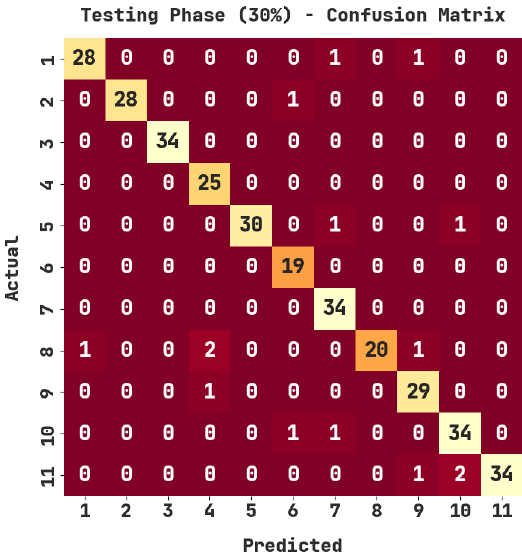
Figure 5. Confusion matrix of ASODCAE-SLR approach under 30% of TS data.